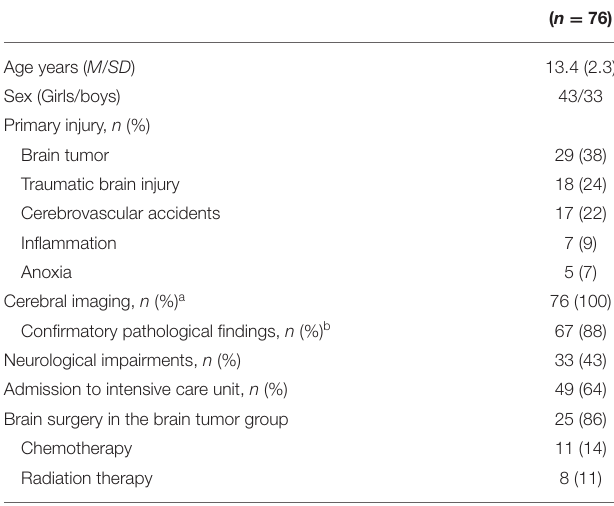
TABLE 1 | Demographic and medical characteristics in study